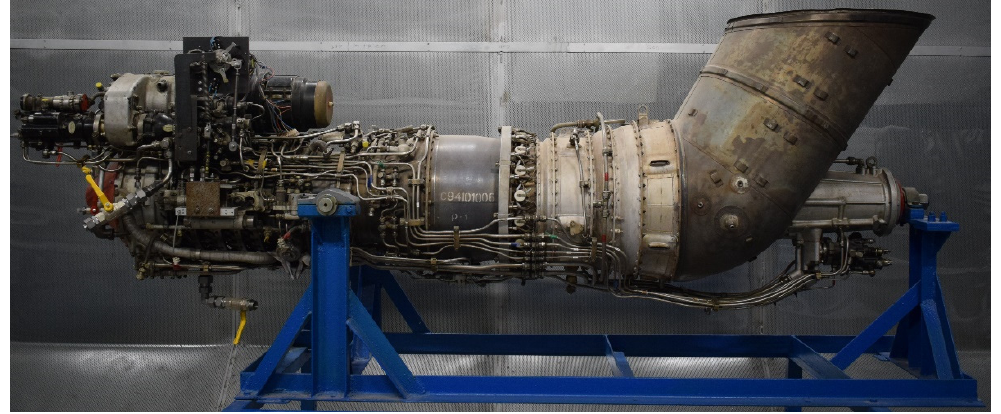
Figure 2. TV2-117A free turbine turboshaft.